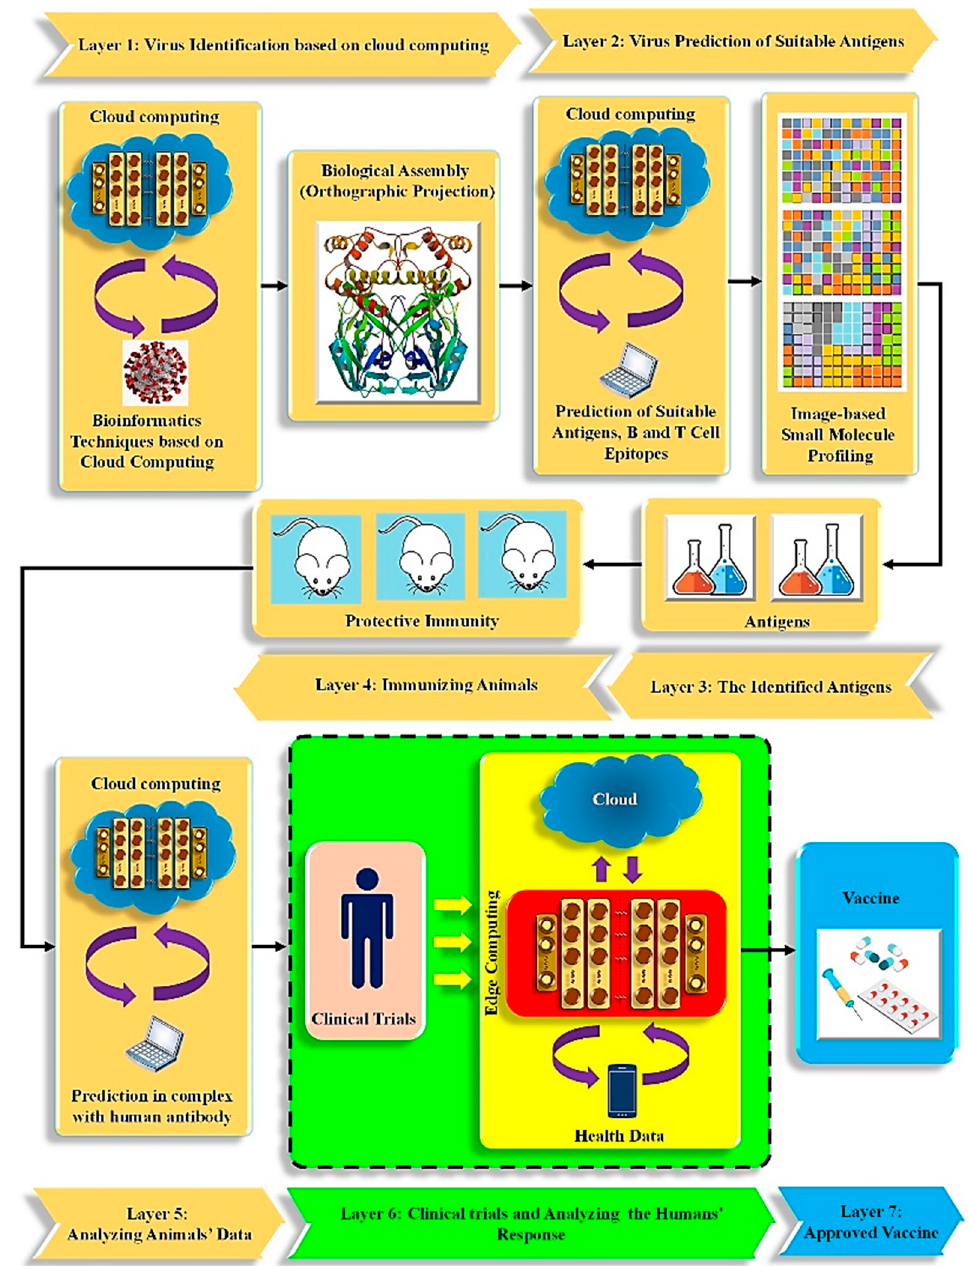
Figure 1. Proposed AI-Powered Strategy for Vaccine Development: A Seven-Layer Approach from Crystal-Structure Modeling to Approval. This schematic diagram illustrates a novel approach to vaccine development that leverages the power of Artificial Intelligence (AI) across seven layers. The process begins with the modeling of crystal structures, which are shown in the diagram to explain how the proposed method works. By using AI algorithms to analyze large amounts of data and make predictions about vaccine candidates, researchers can optimize the efficacy and safety of potential vaccines. This strategy has the potential to significantly accelerate the development of effective vaccines, as it allows researchers to prioritize the most promising candidates for further testing and clinical trials. The crystal structures shown in the diagram were extracted from [27] , indicating that the proposed AI-powered strategy is based on previous research and findings in the field of crystallography.